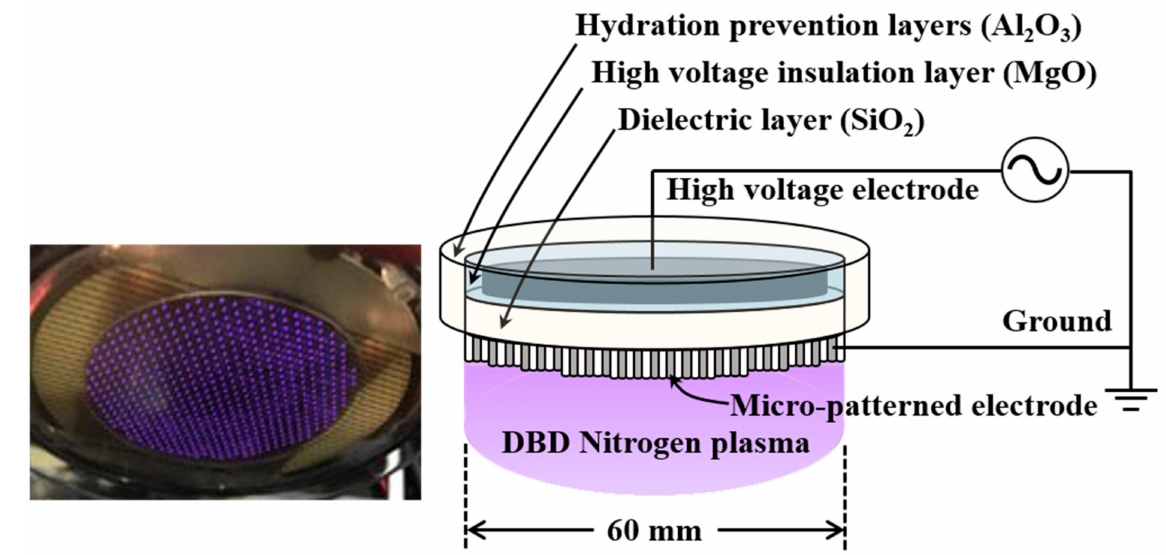
Figure 1. µ -DBD plasma. Plasma discharge appearance and schematic